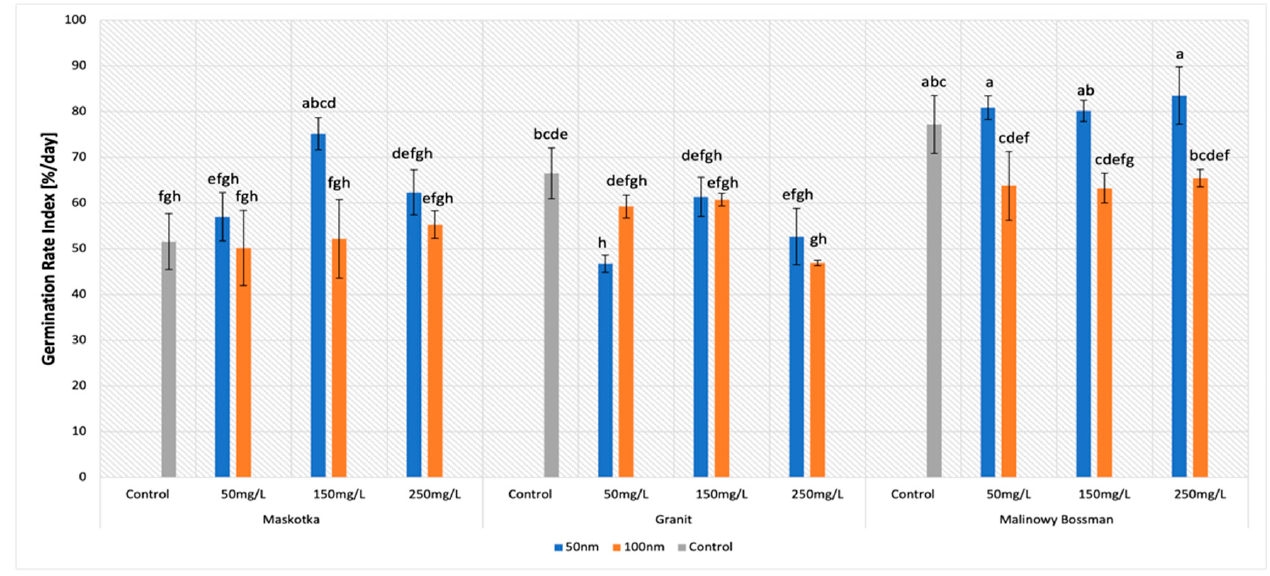
Figure 4. Effect of zinc oxide NPs on the germination rate index (GRI) of tomato seeds after 5 days of incubation. All data are the mean of 3 replicates and vertical bars demonstrate standard deviation (±SD). Different letters indicate the significant differences for p -value ≤ 0.05 (Table A2).